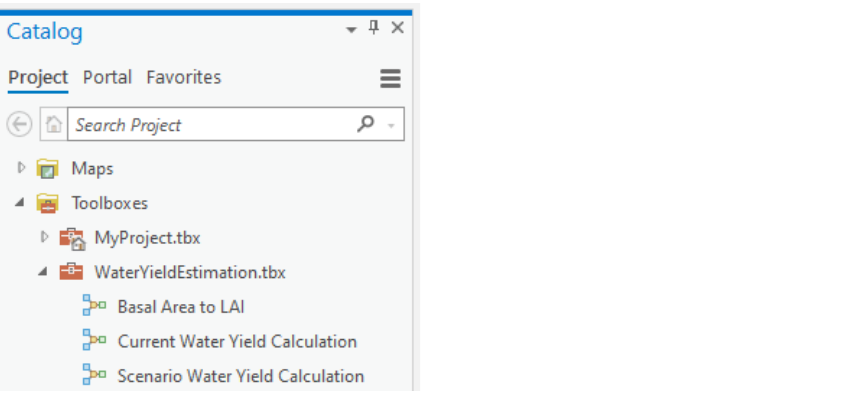
Figure A3. Three geoprocessing tools that appear within the Water Yield Estimation toolbox. Basal Area to LAI: